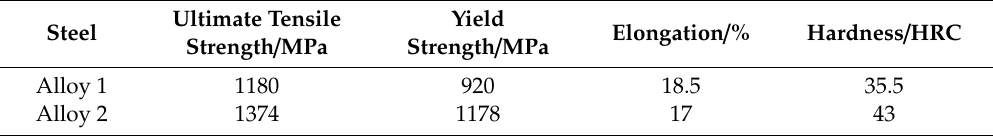
Table 7. Mechanical properties of alloy 1 and alloy 2 after heat-treatment processes.